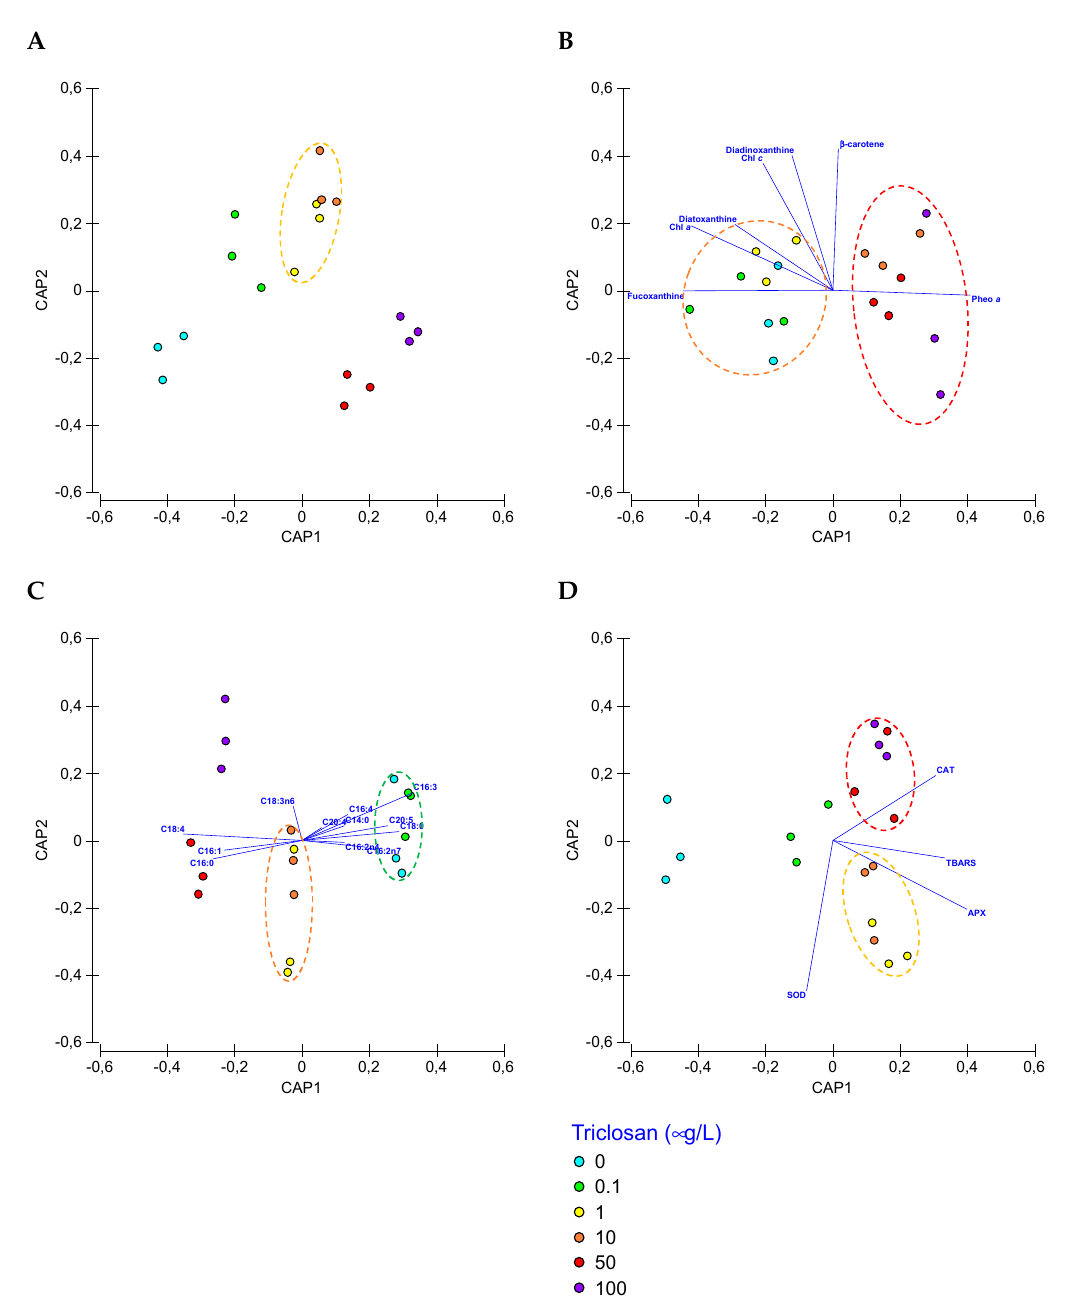
Figure 9. Canonical analysis of principal (CAP) components of the bio-optical data ( A ), pigment concentrations ( B ), fatty acids profiles ( C ), and oxidative stress biomarkers ( D ) obtained from the analysis of Phaeodactylum tricornutum cultures exposed to the different triclosan concentrations.